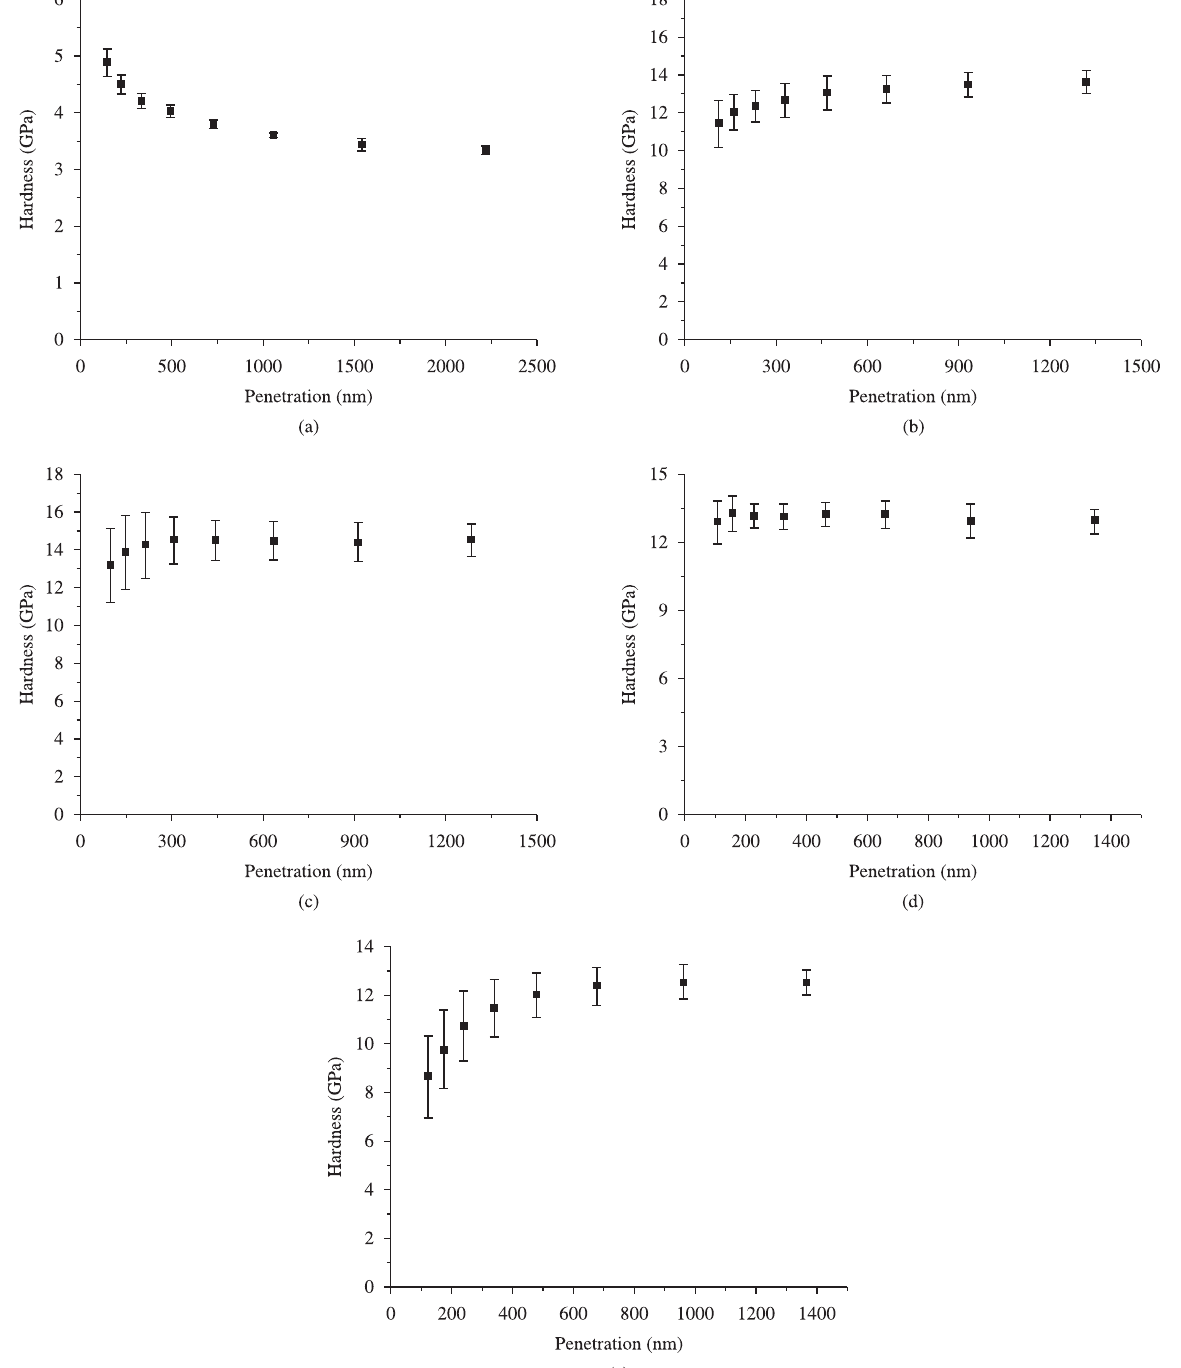
Figure 5. Nanoindentation results for different nitriding conditions: a) Non-nitrided; b) 20% N e) 5% N – 6 2